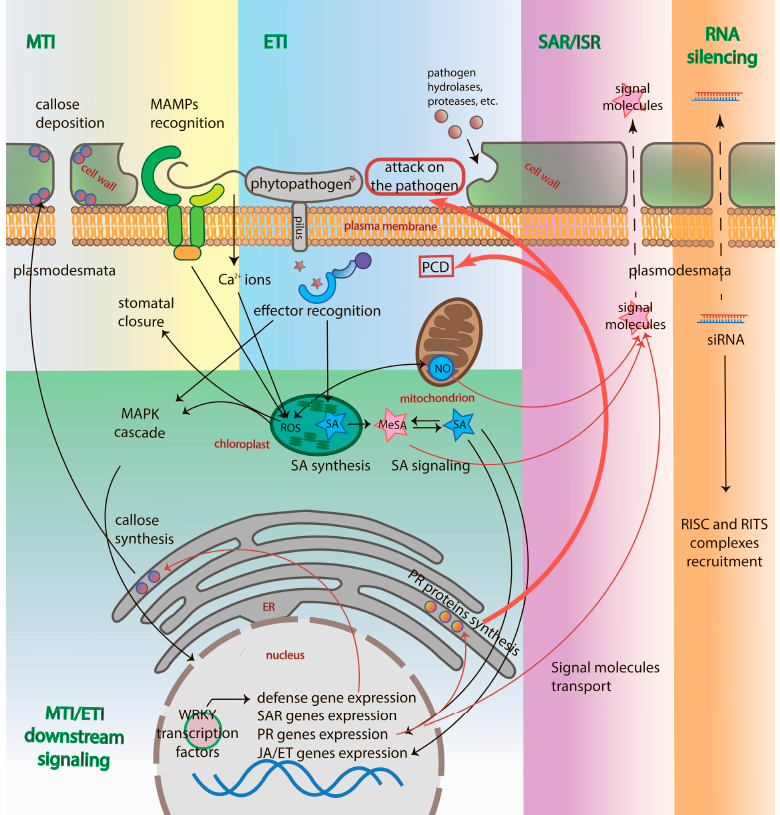
Figure 1. Plant defense mechanisms. MTI is triggered by MAMPs, leading to the elevation of cytosolic calcium ions, ROS and RNI generation, callose deposition at plasmodesmata and stomatal closure [39]. Effectors trigger ETI through binding to R proteins (NB-LRRs) that induce the signaling of SA and the subsequent induction of PR, JA/ET-dependent ISR-related genes and SAR-related genes. PR proteins, such as chitinases, β -1,3-glucanases, proteases, etc., either directly attack the pathogen or induce the PCD of the infected cell. SA is converted into MeSA that is transported into distal parts of the plant, as well as other signal molecules, establishing SAR or ISR. siRNA are also transported into distal parts of the plant through plasmodesmata. Names of immune processes are colored green. The names of cellular compartments are colored red. Black arrows indicate the directions of the activated plant immunity signaling pathways; red arrows indicate the results of genes expression after immunity activation; red bold arrows point to the cell fate in response to the pathogen; dotted arrows indicate the transport of signaling molecules through plasmodesmata.